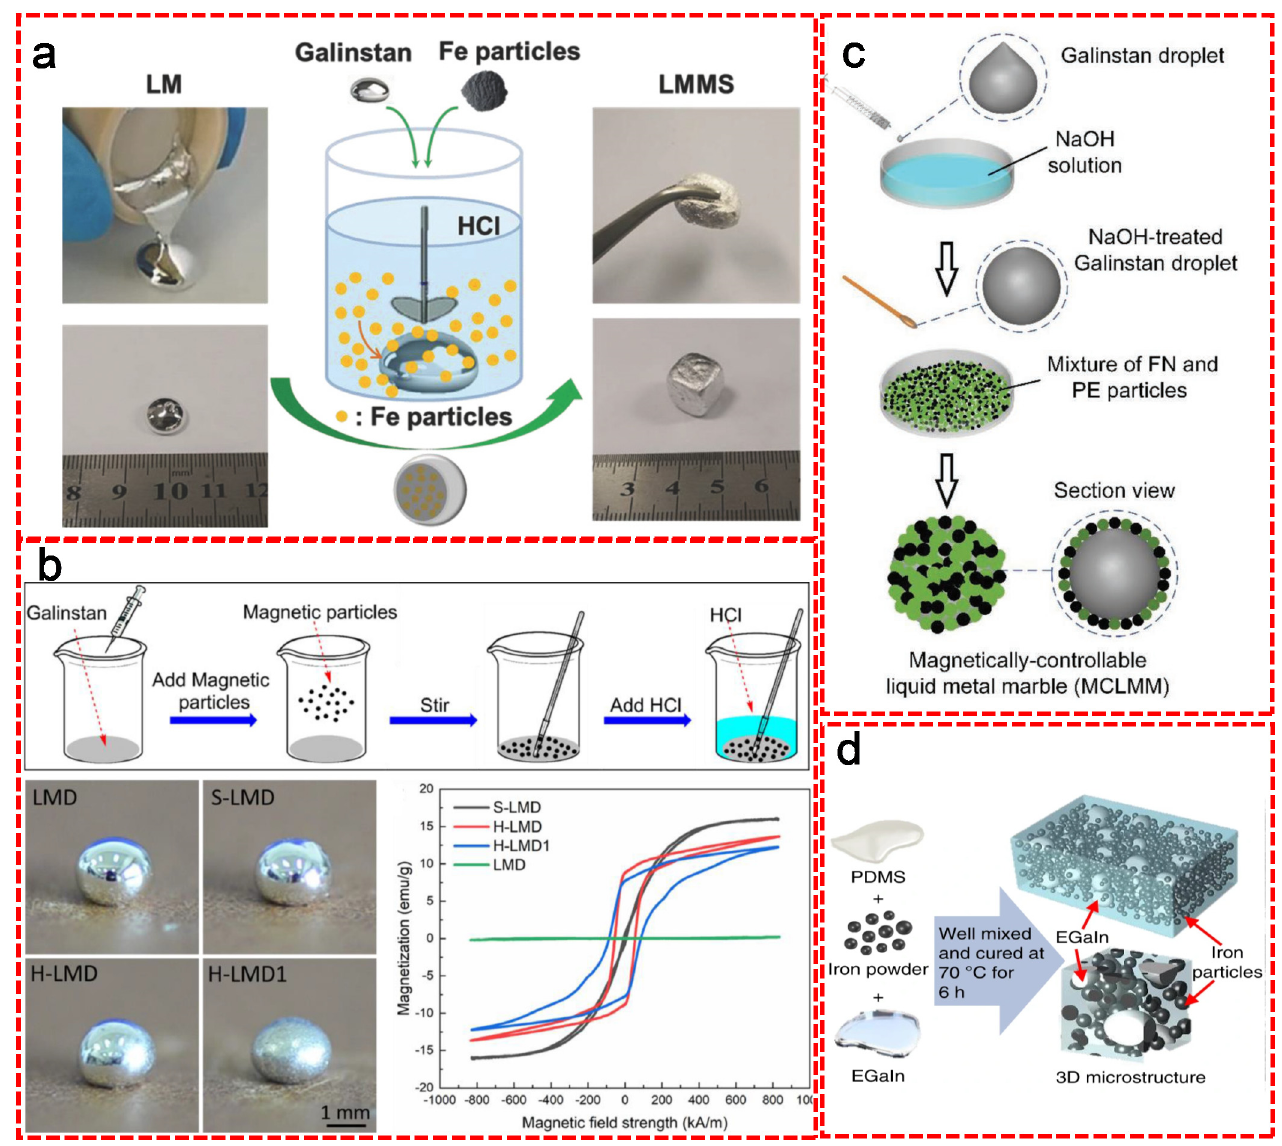
Figure 6. Fabrication of magnetically responsive LM composites. ( a ) Schematic illustration and photographs demonstrating the fabrication of LMMS. Reproduced with permission. [46] Copyright 2018, WILEY-VCH. ( b ) Schematic diagram of the preparation process of magnetic liquid metal. Optical images of the pure liquid metal droplet (LMD), magnetic liquid metal droplet with Fe particles (S-LMD), large-sized NdFeB particles (H-LMD1) and small-sized NdFeB particles (H-LMD). The magnetic hysteresis loops of the three kinds of MLMDs. Reproduced with permission. [47] Copyright 2021, Elsevier B.V. ( c ) Schematic diagram of the fabrication of the magnetically controllable liquid metal marble (MCLMM). A mixture of ferronickel (FN) and polyethylene (PE) particles was spread evenly in a Petri dish. Reproduced with permission. [48] Copyright 2019, WILEY-VCH. ( d ) Schematic of the procedure for fabricating the liquid metal-filled magnetorheological elastomer. Reproduced with permission. [49] Copyright 2019, Springer Nature